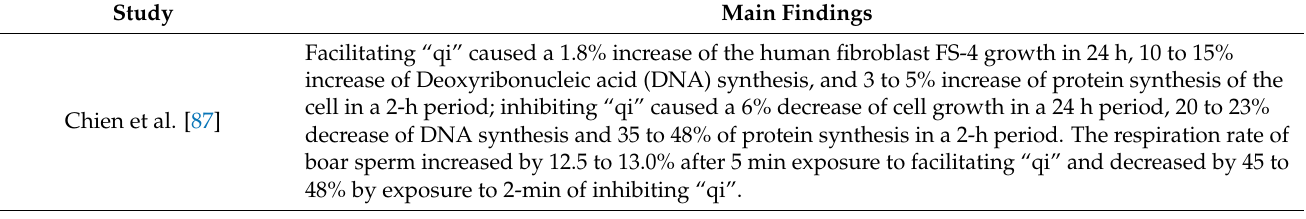
Table 2. Research exploring the effects of non-contact biofield practices on biological materials. Main